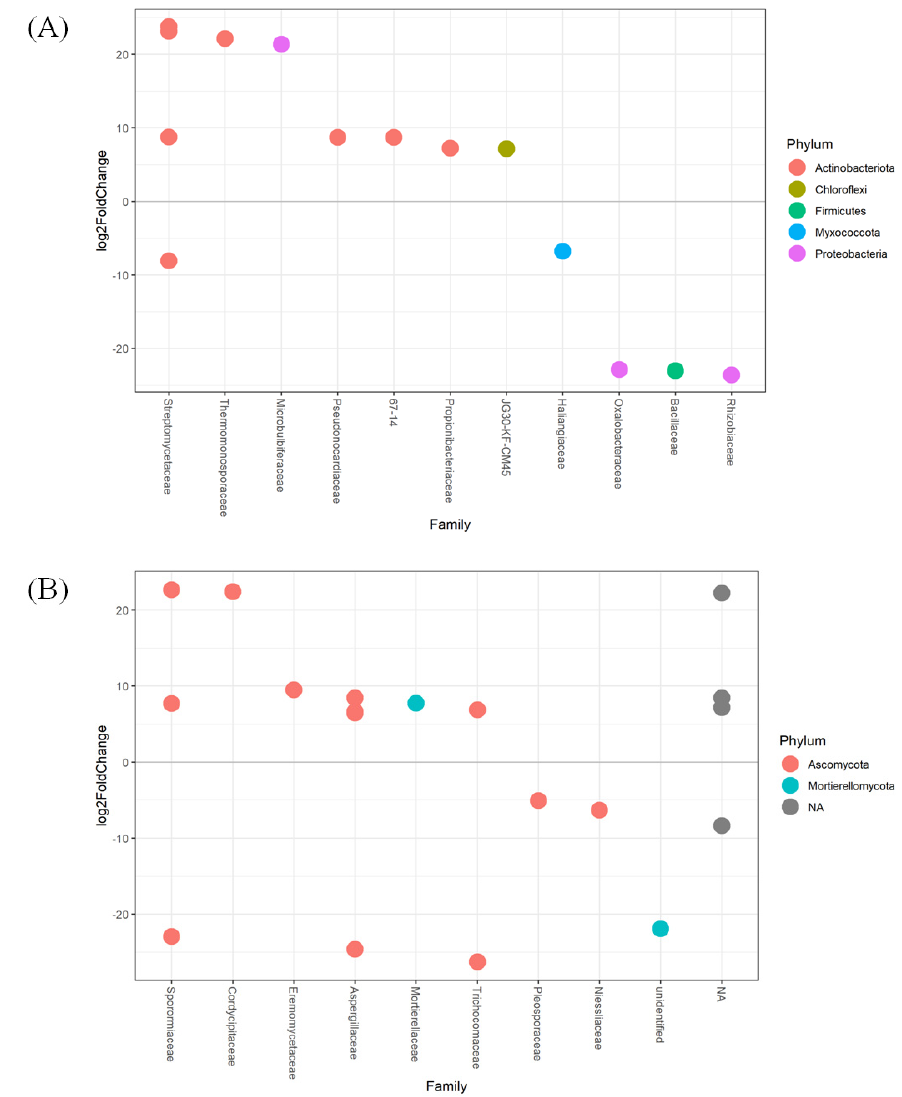
Figure 6. Bacterial ( A ) and fungal ( B ) amplicon sequence variants (ASVs) that significantly differ in abundance in unamended barley (control) vs. compost-amended barley when all barley growth stages are considered. Tillering (S1), booting (S2) and ripening stage (S3). 3.5. Metabolic Functional Features of the Microbial Community Present in Barley Rhizosphere